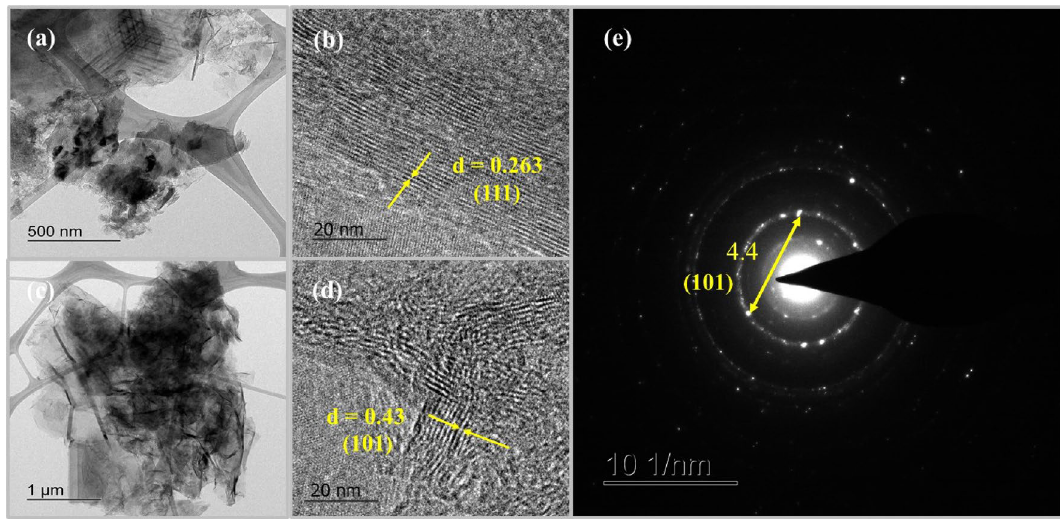
Figure 5. ( a – d ) TEM and HRTEM images of Pristine, Mn-doped MnYP-600HTT and MnYP-800HTT, ( e ) SAED pattern of Mn-doped